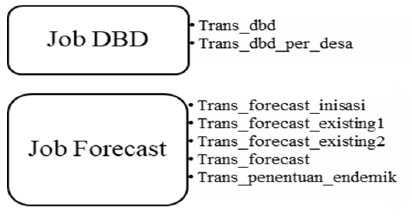
Fig. 3. Transformation